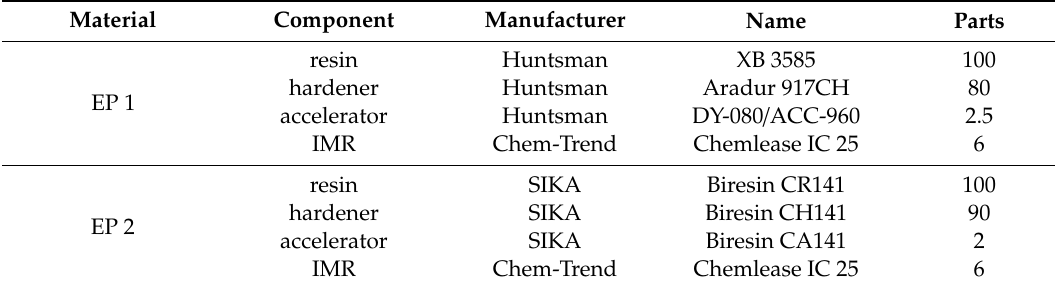
Table 1. Resin systems.